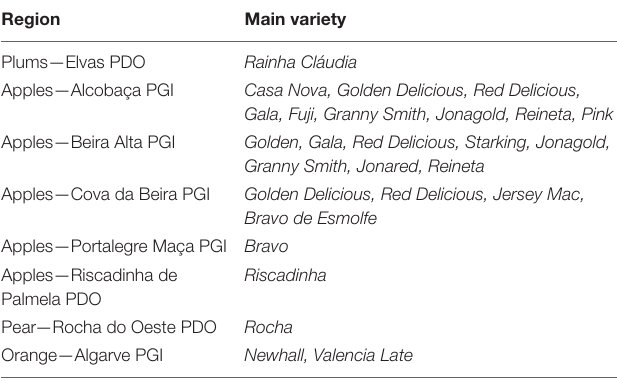
TABLE 1 | Fresh fruit regions and main fruit varieties grown in Portugal according to the DGADR (Direção-Geral de Agricultura e Desenvolvimento Rural,